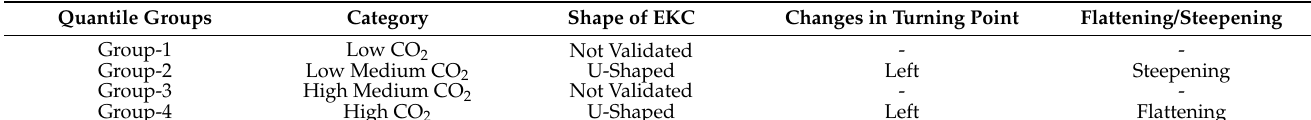
Table 6. Moderation (Transportation Competitiveness) for Observing Changes in EKC.